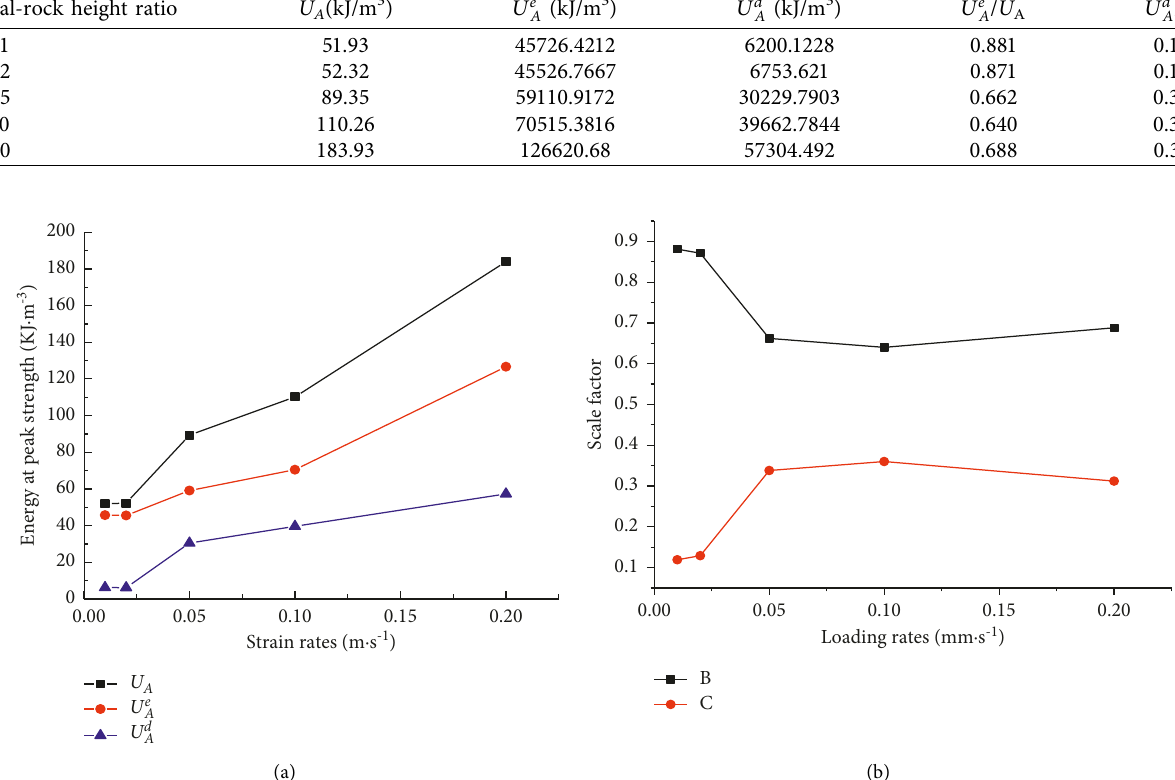
A , recoverable elastic strain energy